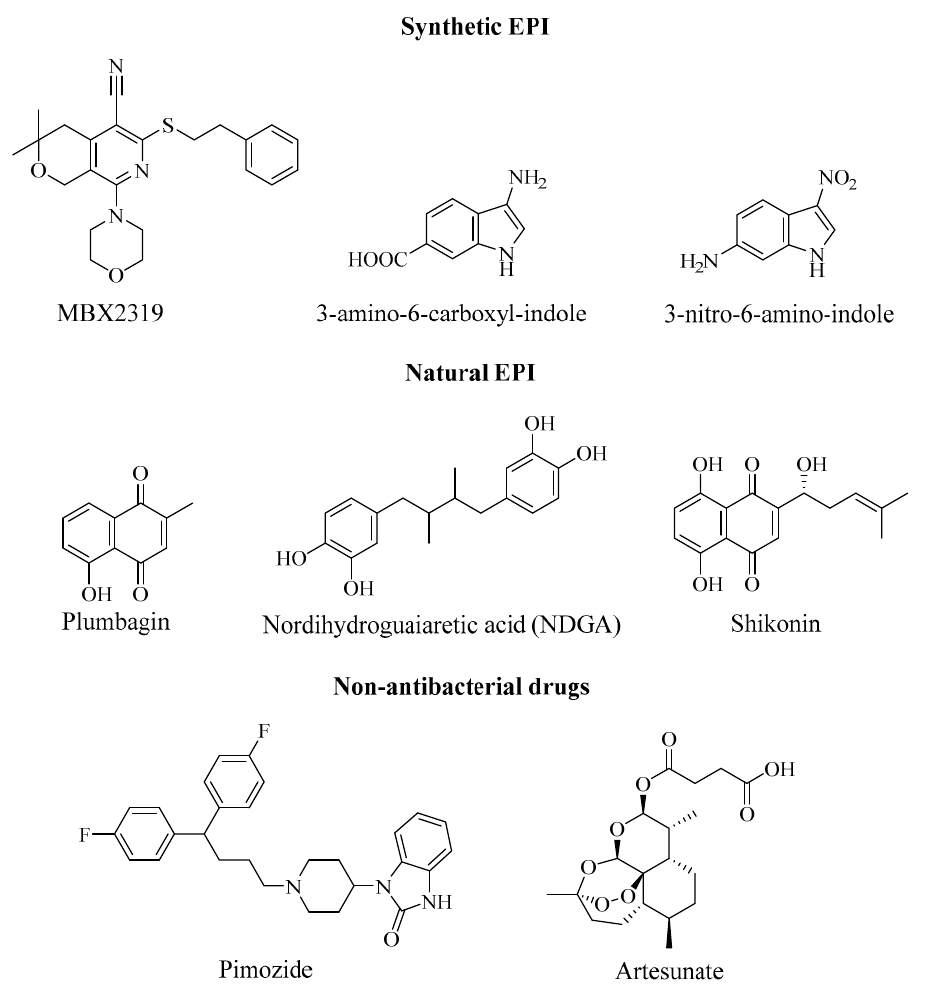
Figure 9. Potential EPIs directed against Resistance Nodulation Division (RND) pumps in E. coli.